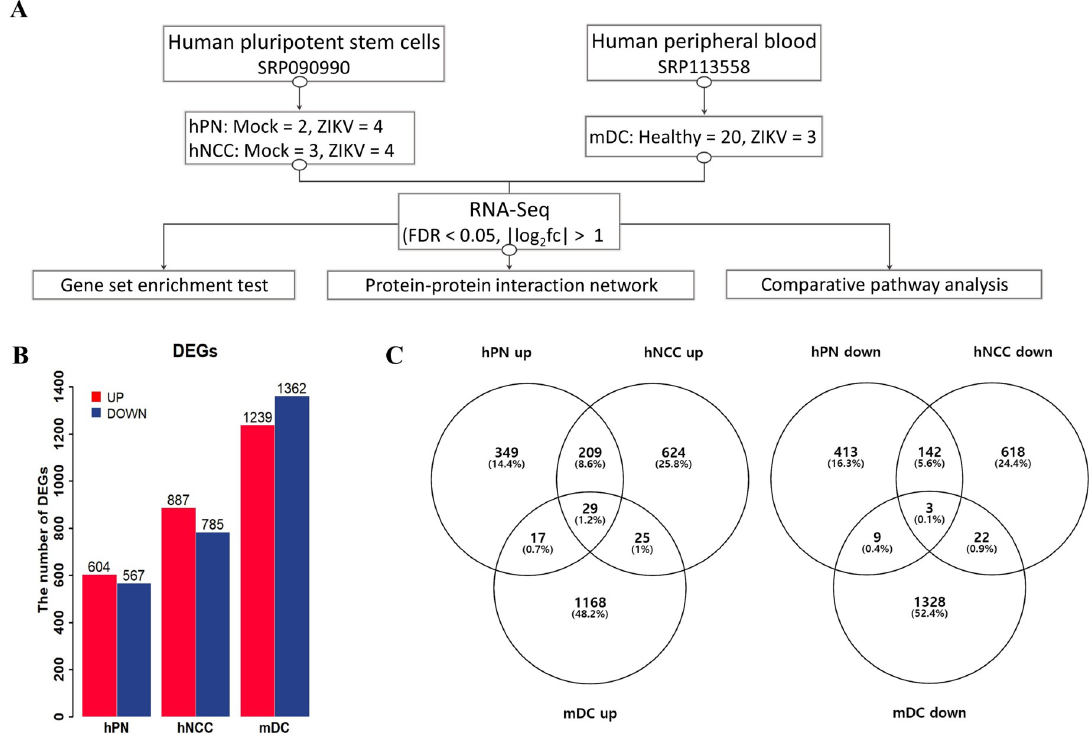
Fig 1. Comparison of cell-specific gene expression between ZIKV-infected cells and uninfected cells. (A) Simple schematic for the three integrated datasets, including three different cell types (hPNs, hNCCs, mDCs). (B) Histogram demonstrating the numbers of DEGs in hPNs, hNCCs, and mDCs. (C) Venn diagrams showing overlap in the number of up- or downregulated DEGs for the three cell types. hPNs: human peripheral neurons, hNCCs: human neural crest cells, mDCs: myeloid dendritic cells.